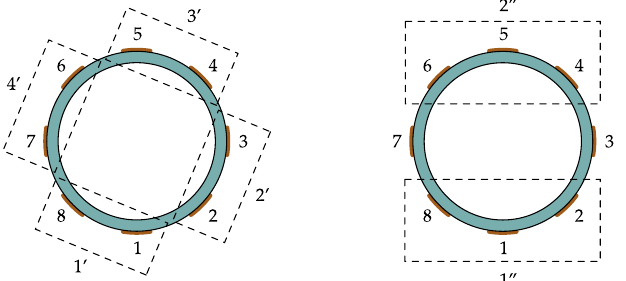
Figure 8. Combining measurements to emulate sensor designs with different numbers of electrodes. Adjacent electrodes are combined to emulate a sensor assembly with four electrodes and a sensor with two electrodes is emulated by combining three electrodes